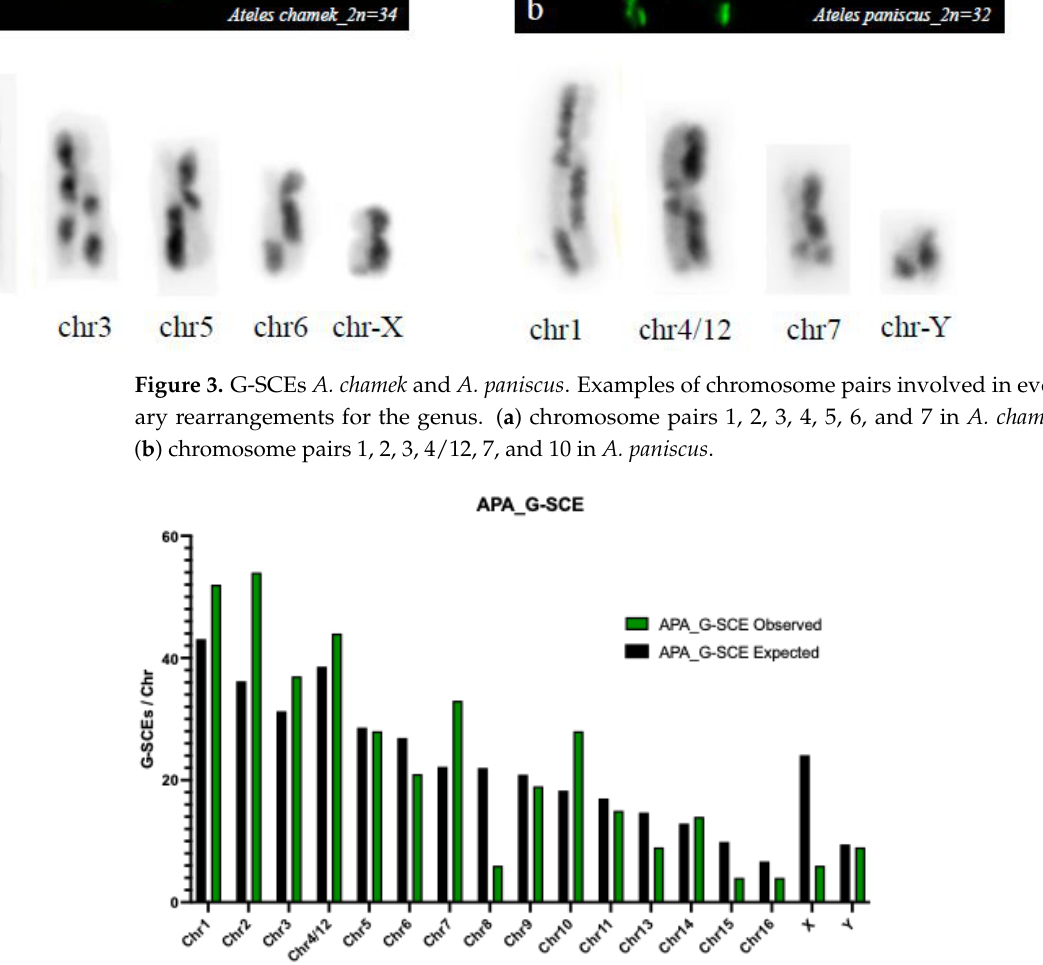
Figure 4. Number of observed (green) and expected (black) G-SCEs for each chromosome pair of A. paniscus .